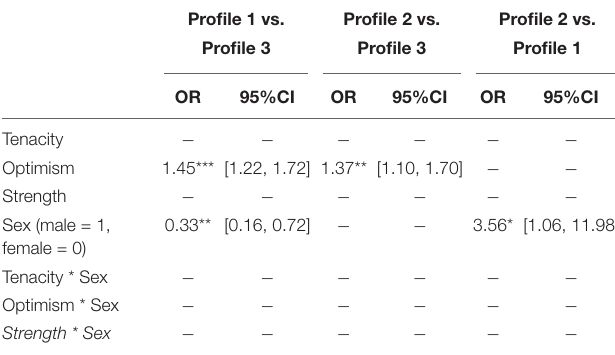
TABLE 8 | Multinomial logistic regression predicting positive affect trajectory class membership (Odds ratios). Profile 1 vs. Profile 2